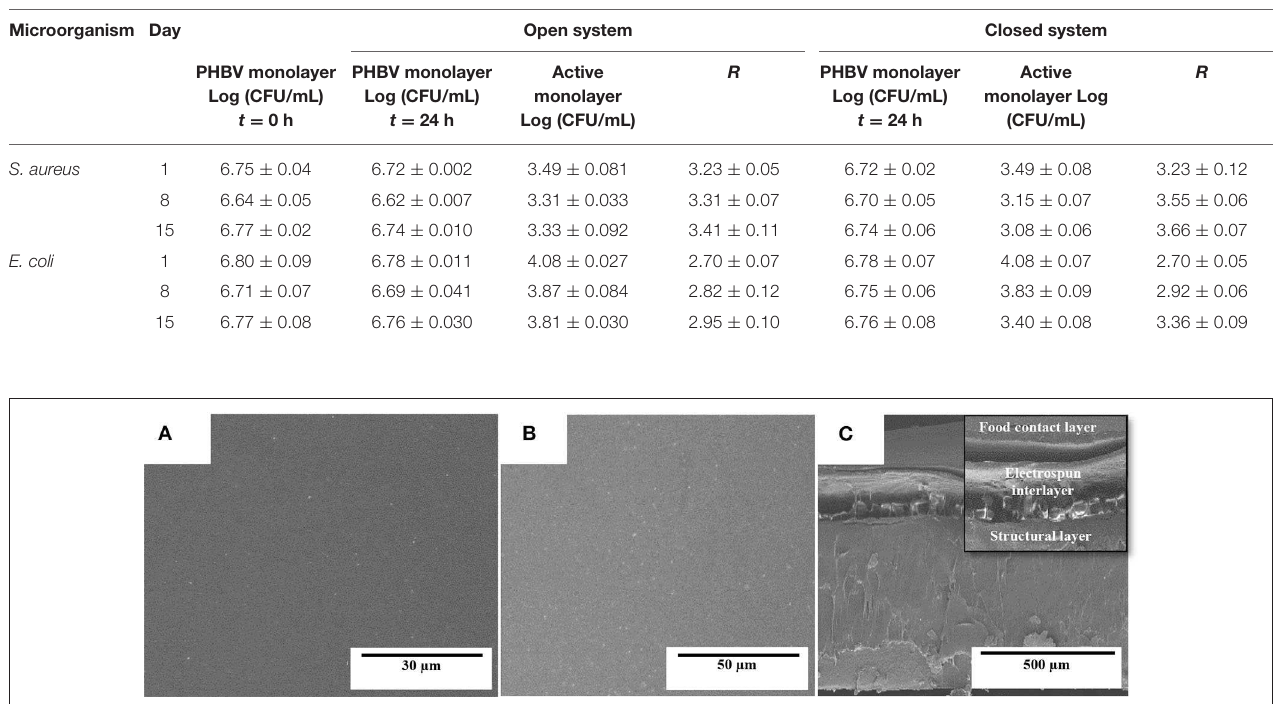
TABLE 3 | Antibacterial reduction (R) for Staphylococcus aureus ( S. aureus ) and Escherichia coli ( E. coli ) of the electrospun monolayers of poly(3-hydroxybutyrate- co -3-hydroxyvalerate) (PHBV) containing 15 wt.% of eugenol in the open and closed systems for 1, 8, and 15 days. Microorganism Day